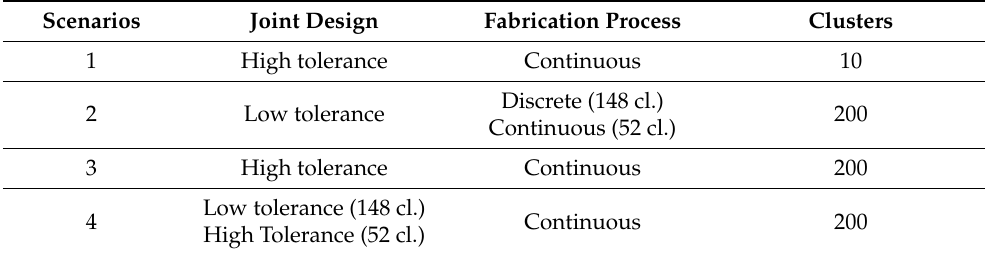
Table 4. Fabrication options for the Singapore Arts Centre structure when different joint designs and fabrication processes are